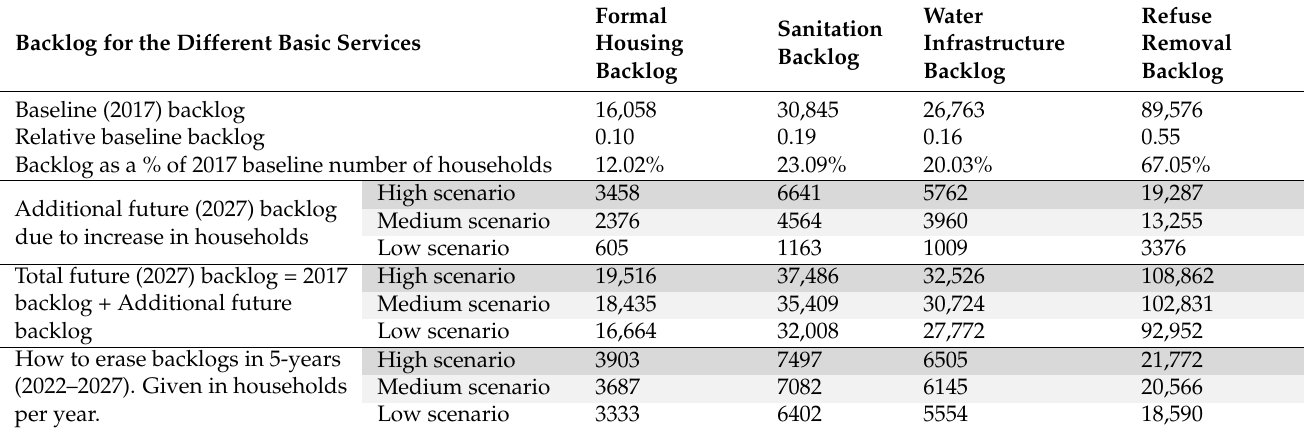
Table 7. Challenges and goals to erase the backlogs in the future (Source: Own construction) .